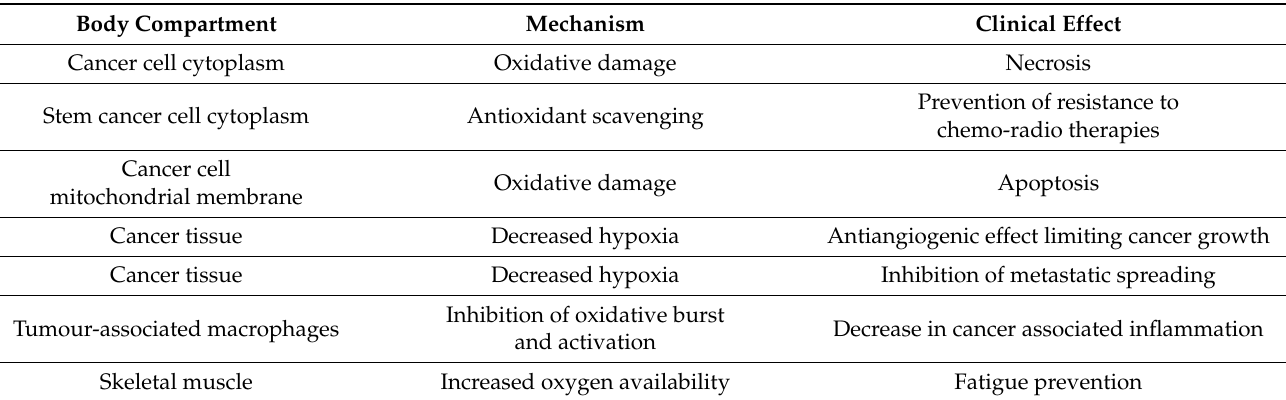
Table 1. Anti-cancer mechanisms activated by ozonized oils at high